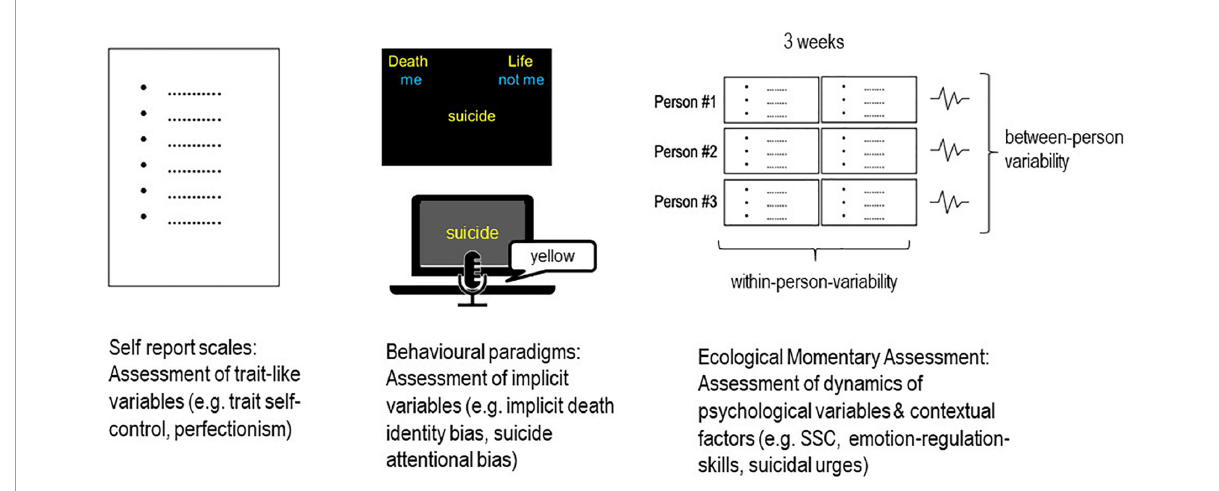
FIGURE2 Research design integrating different assessment methods for investigating psychological variables and